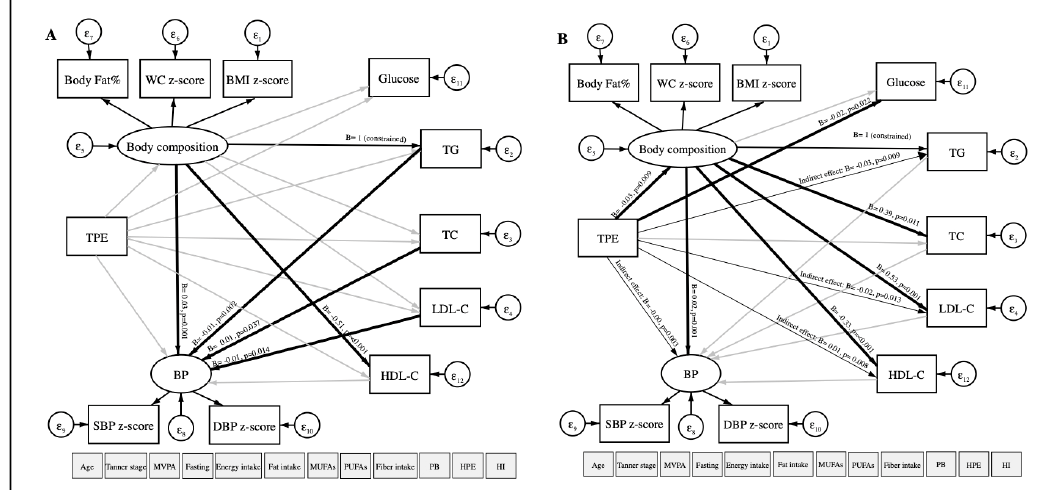
Figure A1. Path diagram of the association between TPE and CVRFs using structural equation modeling in girls ( A ) and boys ( B ). TPE: Total polyphenol excretion in urine. CVRFs: Cardiovascular risk factors. WC: Waist circumference. BMI: Body mass index. BP: Blood pressure. SBP: Systolic blood pressure. DBP: Diastolic blood pressure. TG: Triglycerides. TC: Total cholesterol. LDL-C: Low-density lipoprotein-cholesterol. HDL-C: High-density lipoprotein-cholesterol. MVPA: Moderate-to-vigorous physical activity. MUFAs: Monounsaturated fatty acids. PUFAs: Polyunsaturated fatty acids. PB: Place of birth. HPE: High parental education. HI: Household income. ε : error. Oval circles indicate a latent variable that is not measured directly. Age, gender, MVPA, fasting, Tanner scale, energy intake, fat intake, MUFAs, PUFAs, fiber intake, PB, HPE, and HI were considered as covariates. Significant paths ( p < 0.05) are shown as black arrows, and non-significant paths are shown as grey arrows. Direct associations are presented with wider arrow widths than indirect associations. Unstandardized regression coefficients are at the end of each arrow.